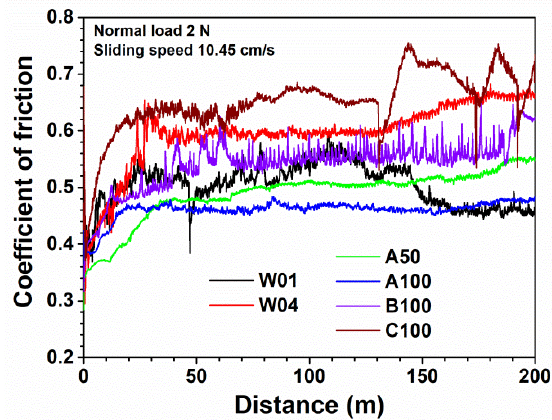
ffi cient of friction of the W–N and W–Si–N Figure 9. The coefficient of friction of the W–N and W–Si–N films. Figure 9. The coe Figure 9. The coefficient of friction of the W–N and W–Si–N films.